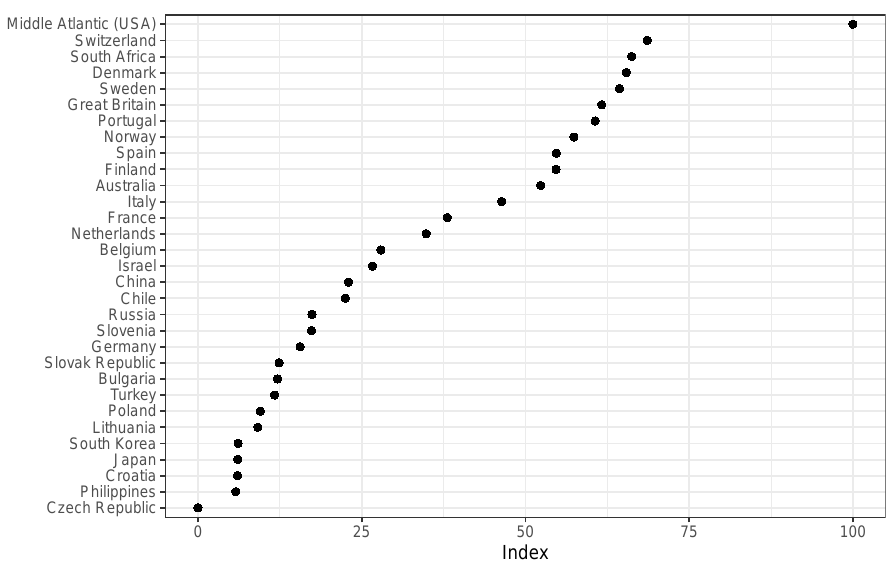
Figure 4. Link index and countries, N =